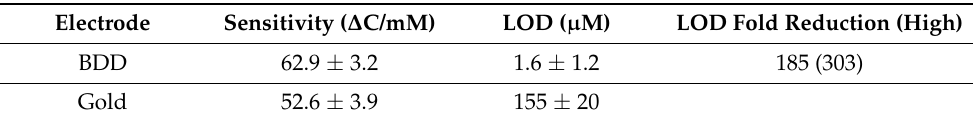
Figure 6. Hexaammineruthenium (II/III) titration and linear regression curves for ( a ) boron-doped diamond versus gold electrodes. ( b ) A before-and-after comparison of oil–membrane implementation for the boron-doped diamond electrode. Table 3. Summary of analytical performance characteristics between boron-doped diamond and gold electrodes for hexaammineruthenium (II/III) in 1× PBS.